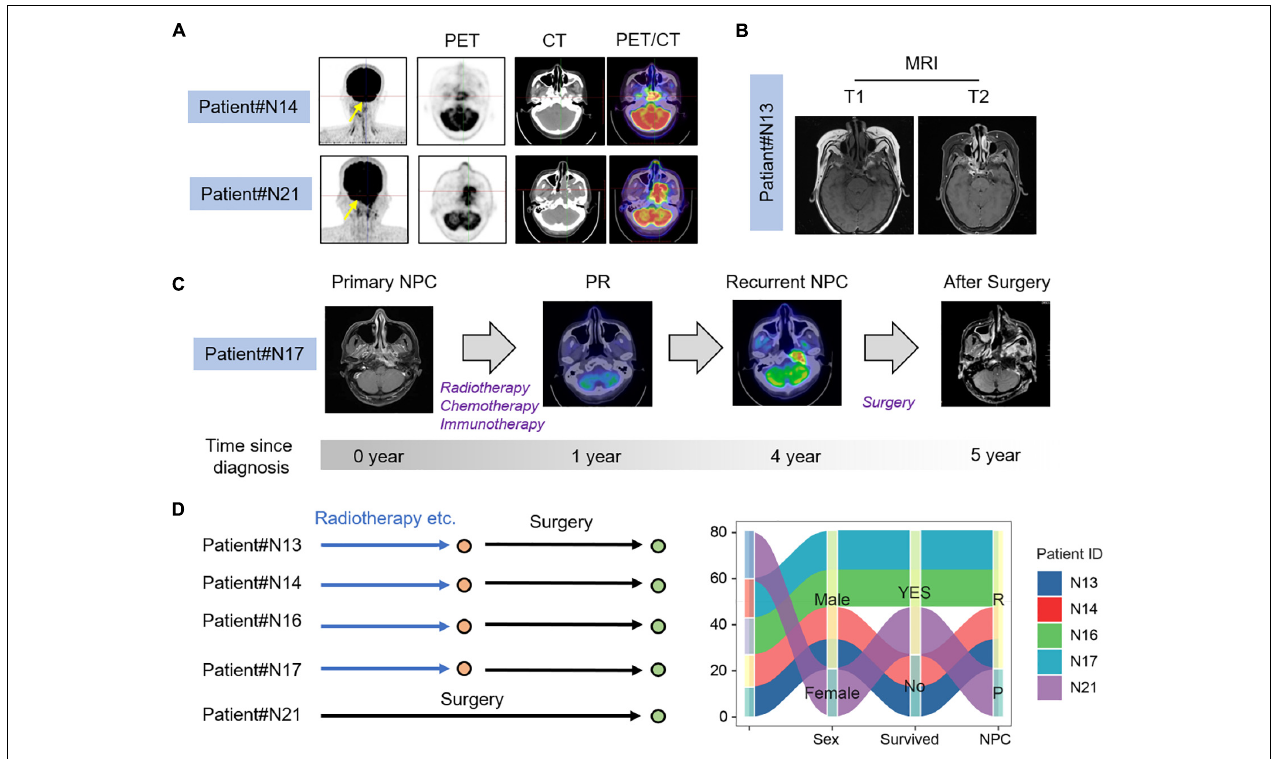
FIGURE 1 | Clinical characteristics of NPC patients. (A) PET-CT image of recurrent and primary NPC patients; (B) MRI images of recurrent NPC patients; (C) Process of treatment for recurrent nasopharyngeal carcinoma patient. (D) Clinical characters and treatment history sanky map of selected NPC